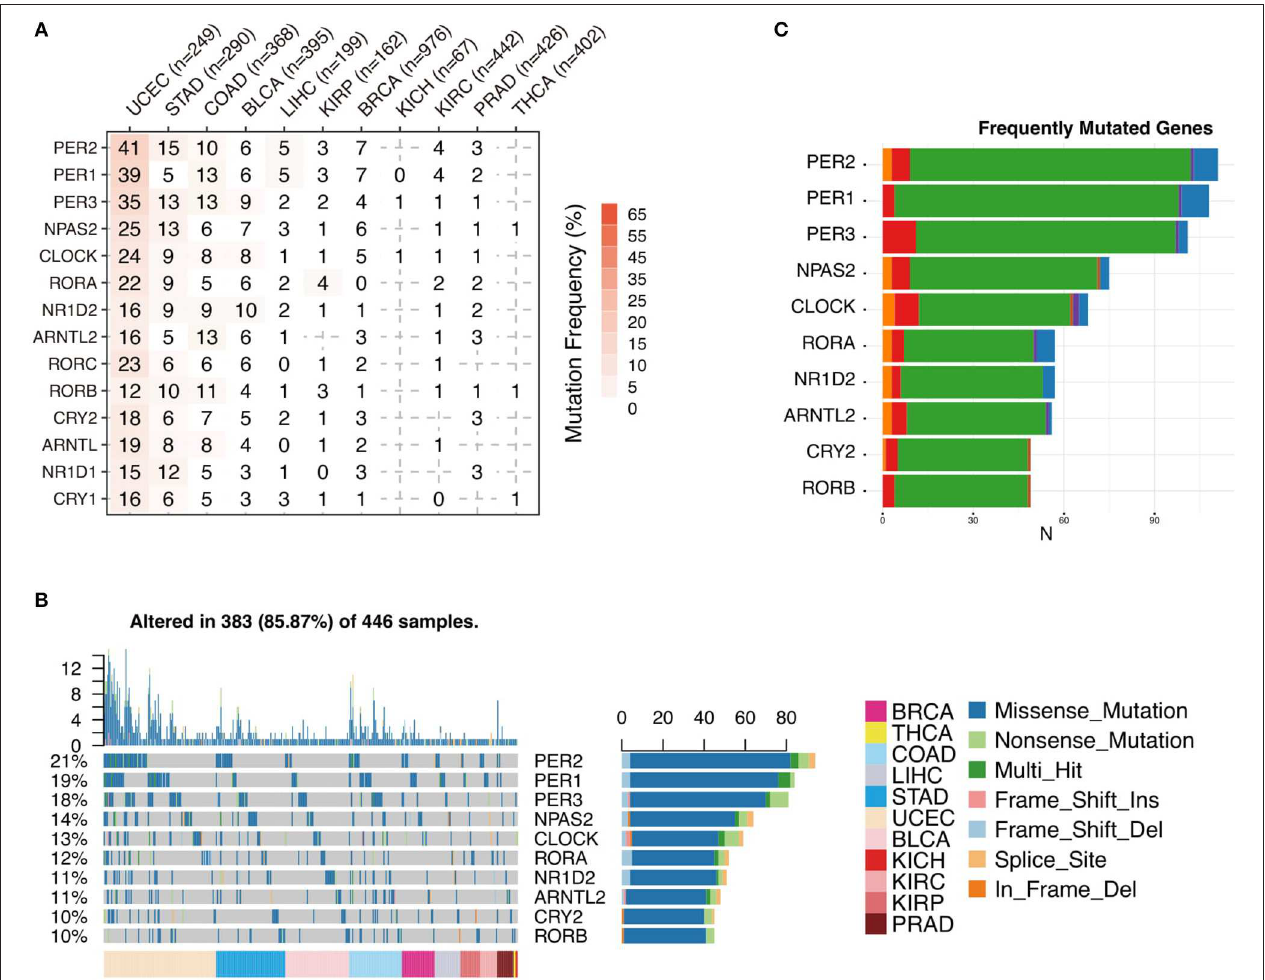
FIGURE 3 | Sequence alteration contributes to abnormal circadian clock. (A) Mutation frequency of core circadian clock genes. (B) Mutation type and summary of core circadian clock genes in cancers. (C) Frequently mutated gene ranking.